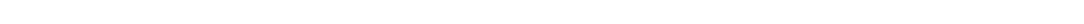
Fig. 2 4HB packs against the α C helix in the hMLKL PsKD and is displaced upon ATP binding. a E351K hMLKL(2 – 471) structure modeled using molecular dynamics based on distance restraints de fi ned by DMTMM crosslinking experiments (Supplementary Fig. 2a, Supplementary Data 1). The α C helix is highlighted in green, while α 3 and α 4 of the 4HB domain (yellow) pack against the α C helix. The RIPK3 substrates, Thr357 and Ser358, are shown as sticks. b Mirror plot demonstrating deuteration (percentage of theoretical maximum) of E351K hMLKL peptides±ATP over the indicated time points. Error bars represent SEM of triplicate experiments. Each tick on the x axis represents an individual peptide. Overlapping or adjacent peptides were identi fi ed for all regions of the protein except for a small section of the N-terminal 4HB. A line break in this region has been introduced to illustrate the gap in sequence coverage (see Supplementary Fig. 3a for peptide sequence coverage). Overlapping regions of peptide coverage are illustrated using tiled lines below the x axis. All SEM values did not exceed ±5.96 from n = 3 independent time course experiments; error bars omitted for clarity. c Differential deuterium uptake of E351K hMLKL peptides ±ATP over the indicated time points (calculated + ATP deuteration minus -ATP deuteration). As in b , each tick represents an individual peptide with a line break introduced to illustrate a gap in sequence coverage. Peptides corresponding to overlapping sequences are shown as tiles below the plot. The corresponding regions of hMLKL the peptides map to are shown schematically between c and d , with sequence elements that undergo differential exchange±ATP highlighted in blue. d Differential hydrogen – deuterium exchange (E351K hMLKL±ATP, 60 min time point) for each analyzed peptide was averaged across overlapping sequences per amino acid residue (excluding the fi rst 2 residues of each peptide due to high rates of back exchange) and mapped onto the E351K hMLKL model (see Supplementary Fig. 3b). Dark gray coloring represents regions of the protein excluded